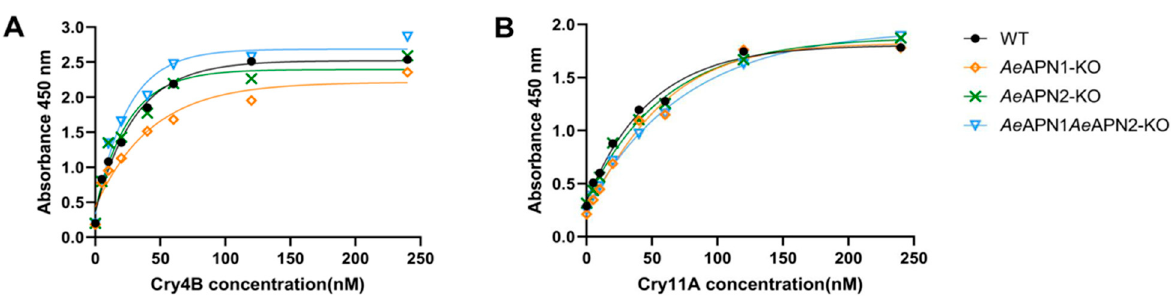
Figure 2. Binding of Cry4Ba and Cry11Aa toxins to Ae. aegypti BBMVs by ELISA. Different concentrations (0 nM, 5 nM, 10 nM, 20 nM, 40 nM, 60 nM, 120 nM, 240 nM) of Cry4Ba ( A ) and Cry11Aa ( B ) protoxins bound to 0.3 µ g midgut BBMVs from APN mutant strains and WT strain in the ELISA plates.